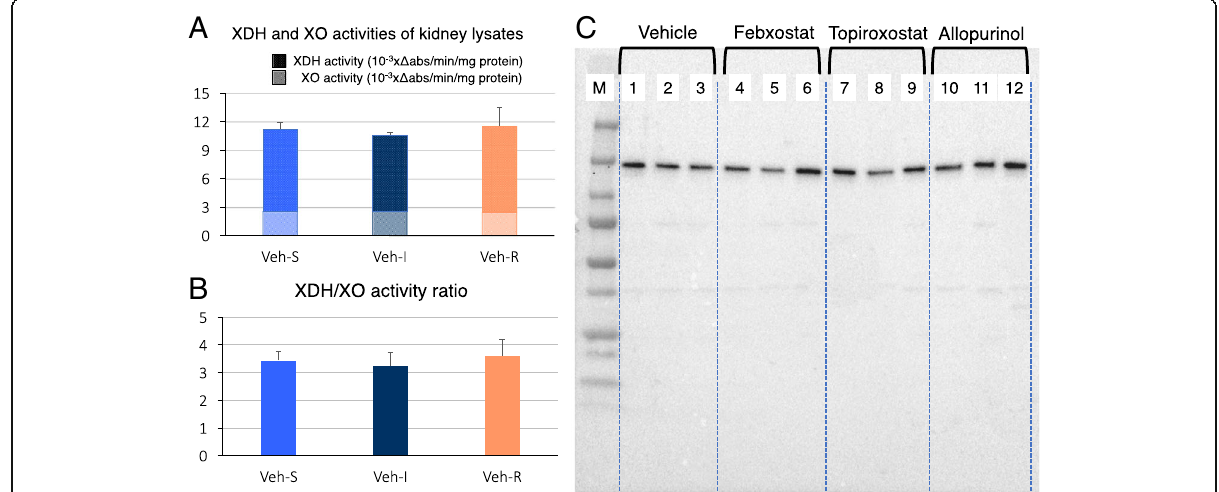
Fig. 1 XOR activity assays and XOR expression in kidney lysates. XOR activity was not detected in kidney lysates of all XOR inhibitor-treated groups. a XDH and XO activity in vehicle-treated rats did not change during I/R injury. b XDH/XO ratios were not altered throughout I/R. c XOR expression in kidney lysates was detected as a 150-kDa single band in each group by western blotting. M, molecular markers; 1 – 3, vehicle-treated rats; 4 – 6, febuxostat-treated rats; 7 – 9, topiroxostat-treated rats; 10 – 12, allopurinol-treated rats. Samples in lanes 1, 4, 7, and 10 are kidney